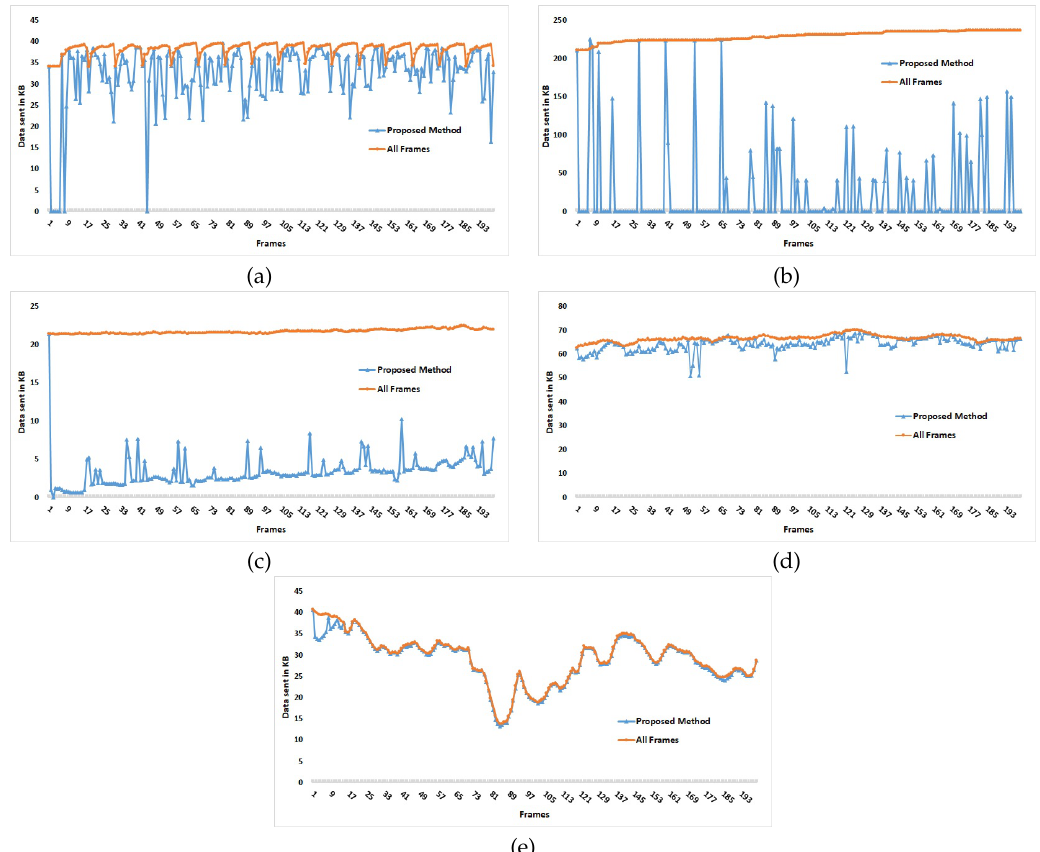
Figure 7. Comparison between the Proposed Method and All Frames in terms of data sent in kB against the first 200 frames of ( a ) Walk ( b ) Ground ( c ) Exercise ( d ) Duval Street ( e )